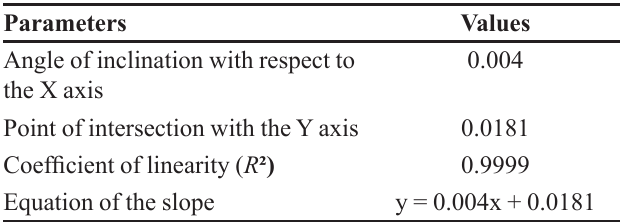
TABLE V – Analytical parameters of the calibration curve